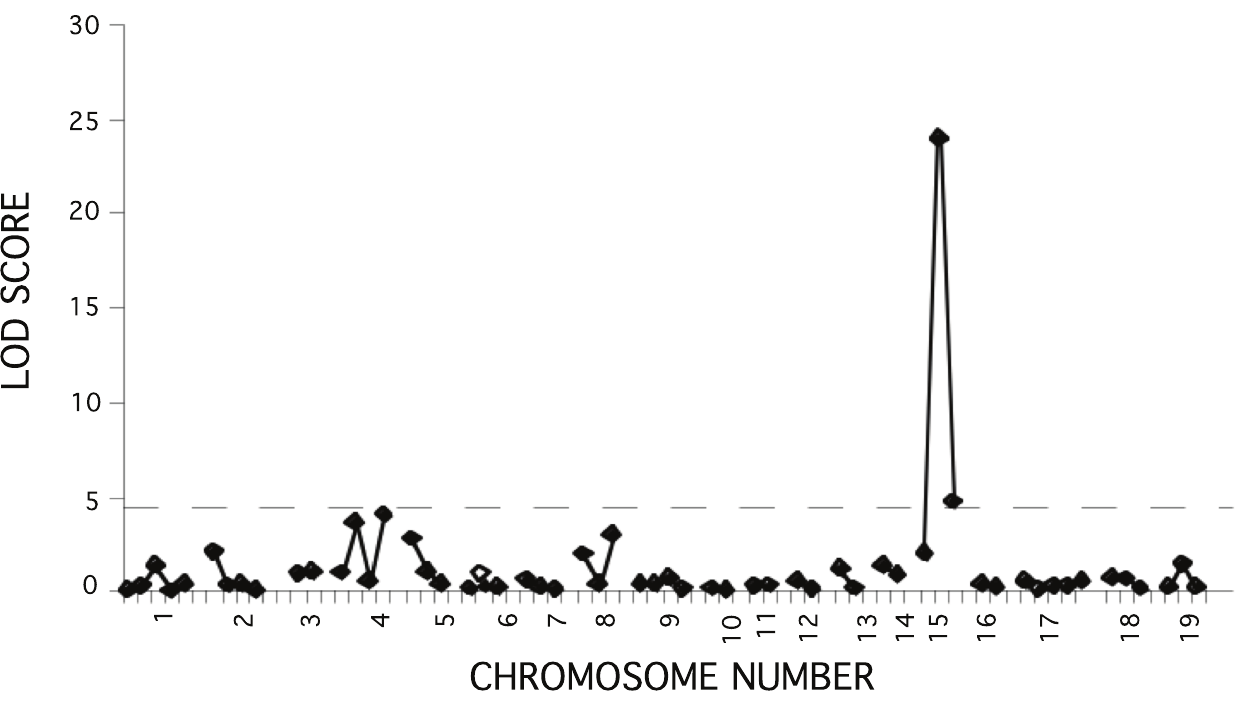
Figure 2. Genome scan to map the str mutation. Affected F2 progeny (n=49) of (NOD. str x DBA/2) F1 parents were typed with microsatellite markers with an average spacing of 20cM over the 19 autosomes. LOD scores were calculated and the dashed line shows the threshold for significance for an F2 genome-wide scan (Lander & Kruglyak, 1995) 8